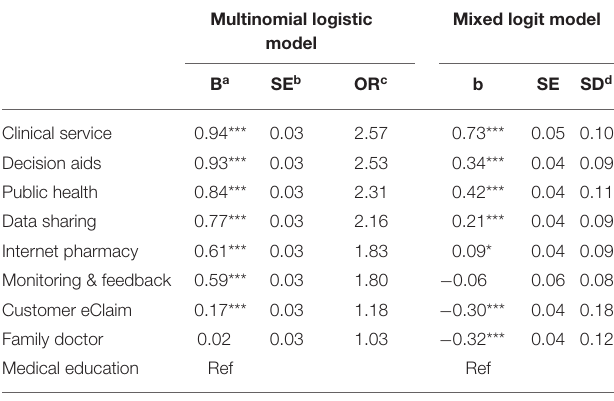
TABLE 5 | Results of multinomial logit regression and mixed logit regression